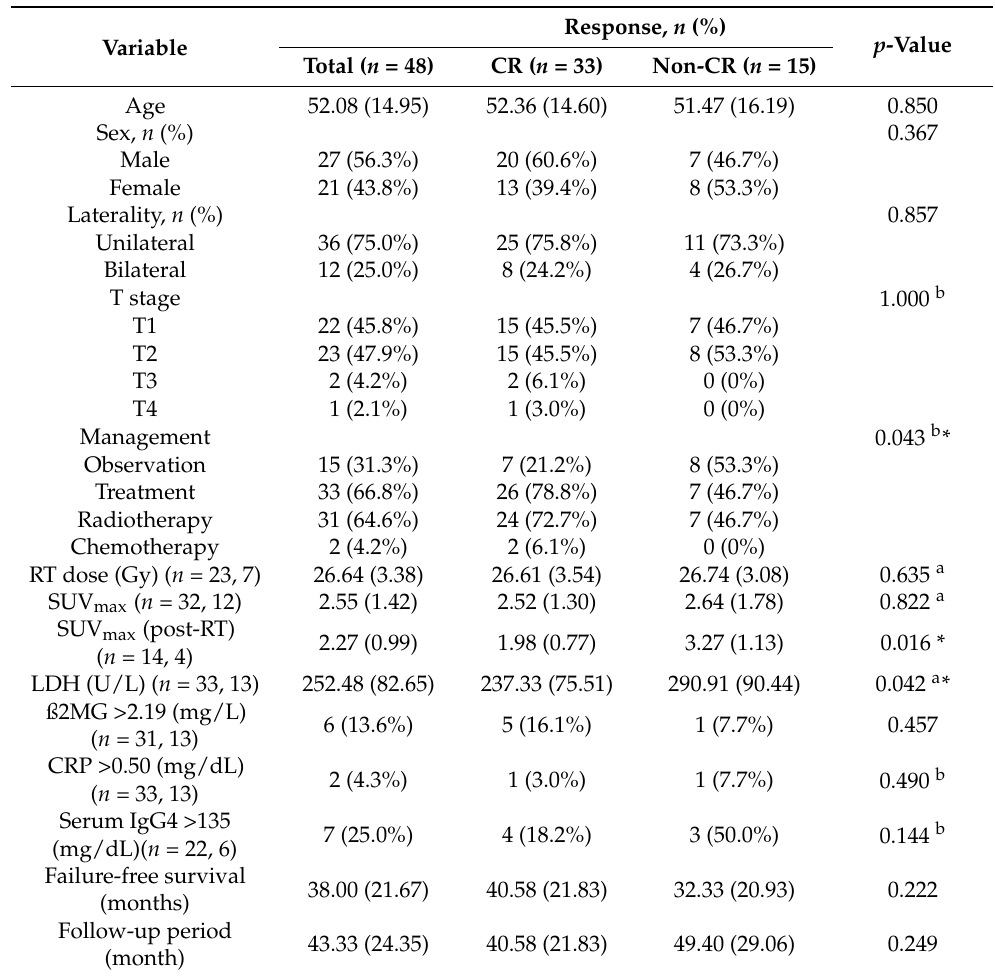
Table 1. Comparison of clinical characteristics in ocular adnexal MALT lymphoma between complete remission group and non-complete remission